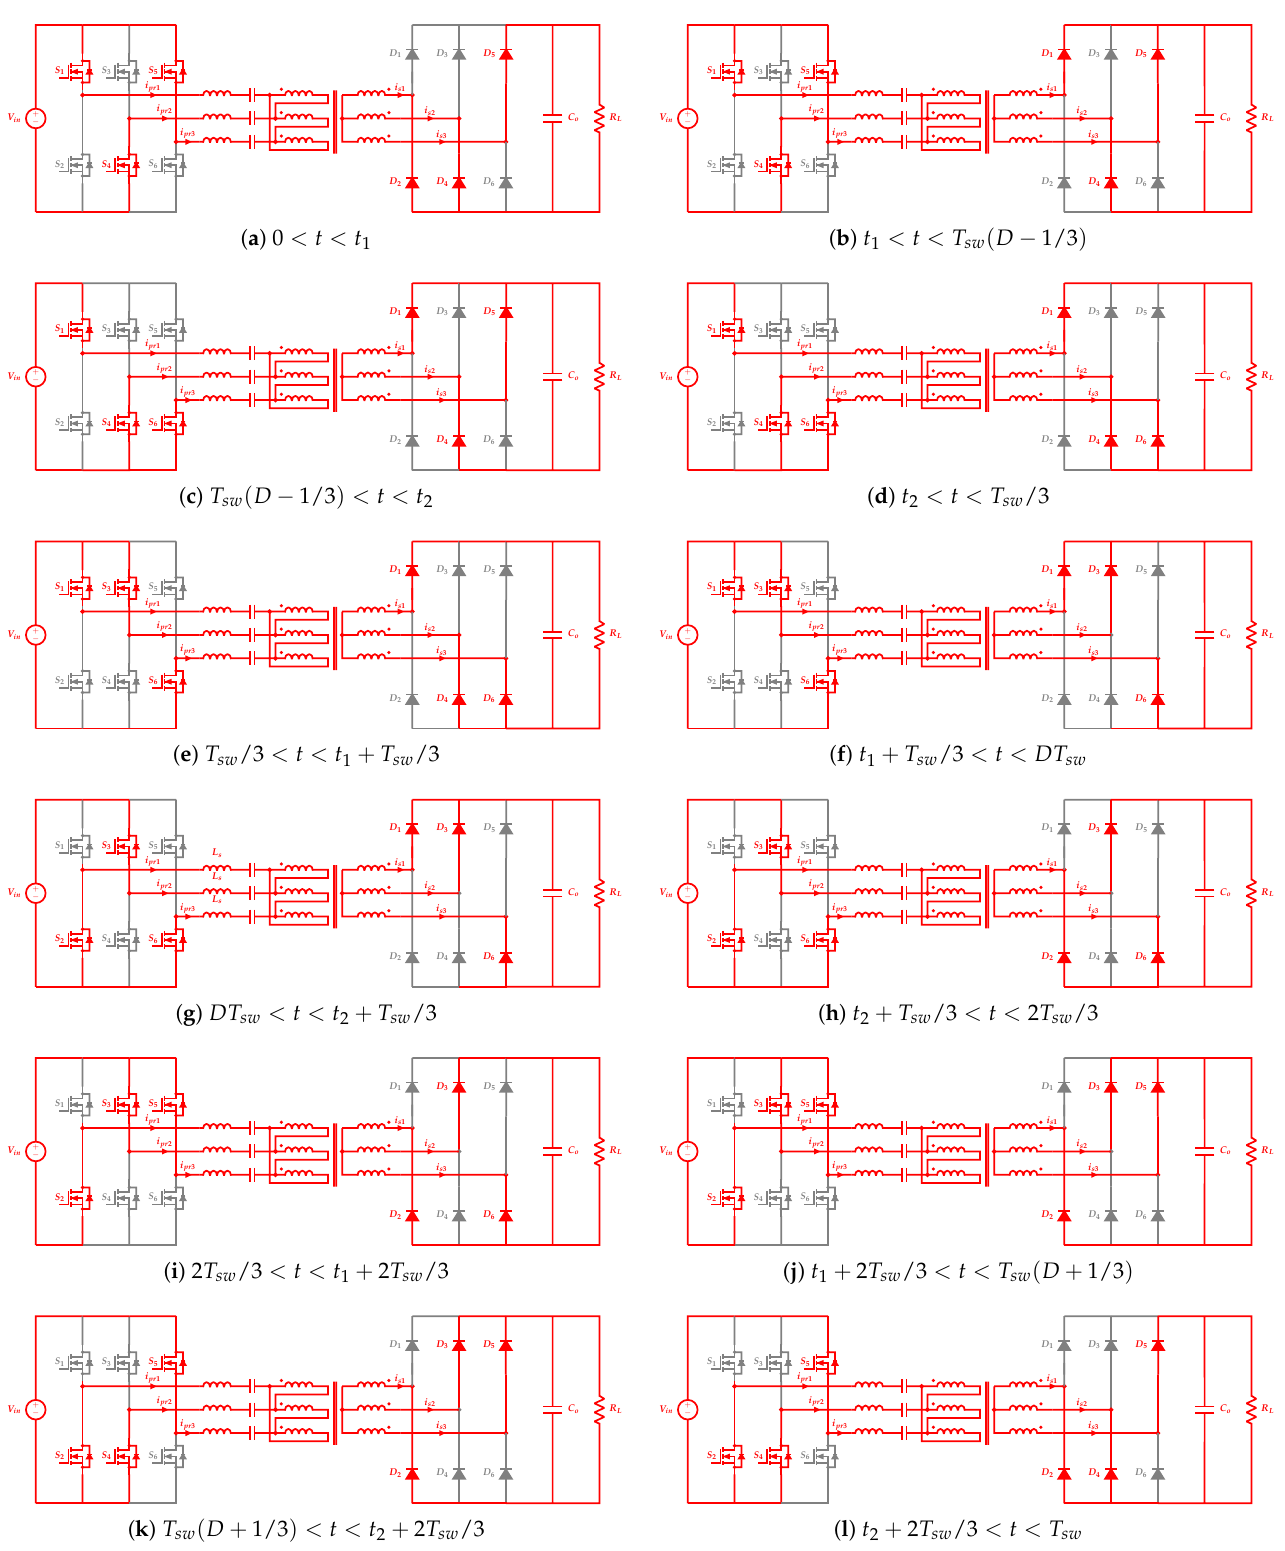
Figure 5. Equivalent circuits in different intervals for CCM1 mode